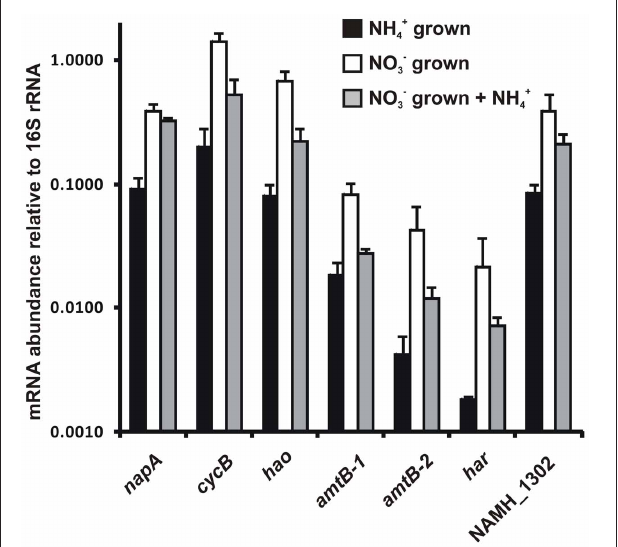
FIGURE 5 | Steady state mRNA levels for key genes encoding enzymes of the reverse-HURM pathway in N. profundicola grown with ammonium + polysulfide (black bars), nitrate + sulfide (white bars), or nitrate + polysulfide after the addition of ammonium. Transcript abundance was determined by fluorescent RT-PCR and normalized to 16S rRNA abundance determined in each sample. Values are averages of 3 independent biological replicates ± the standard